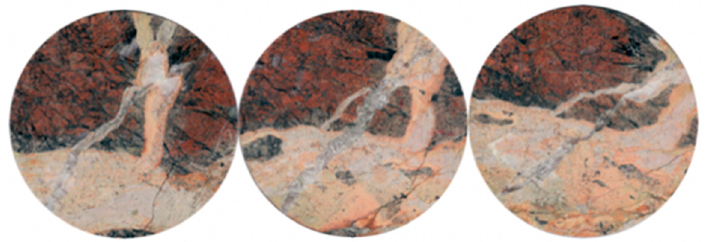
Figure 1. Discs of core sample from borehole R-11 from the depth of 249 m of the “Yeniseisky” site.